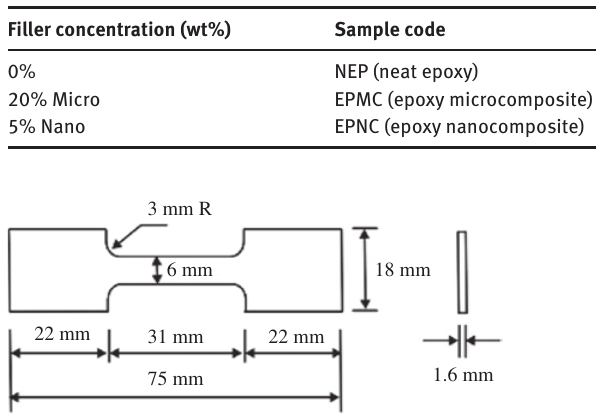
Figure 1: Dog bone sample shape and size.